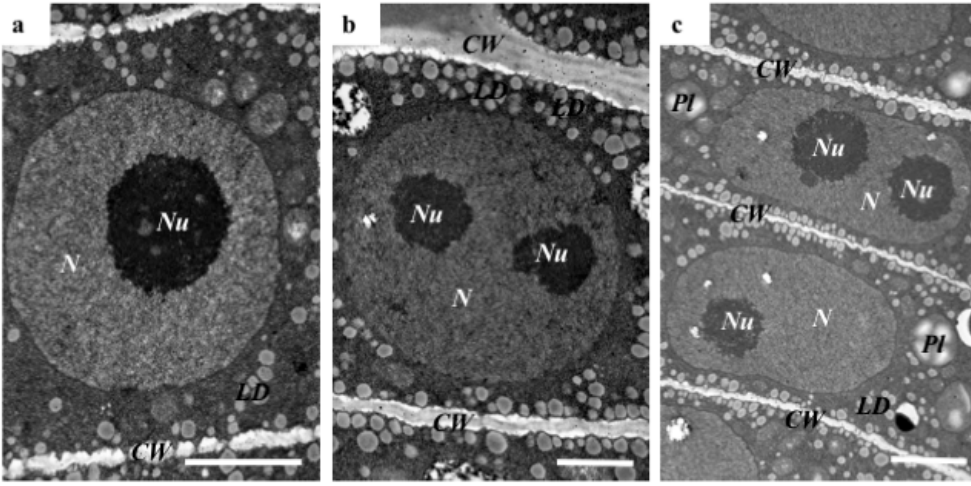
Figure 2. TEM (transmission electron microscopy) of radicula nuclei ( a – c ). Abbreviations: CW —cell wall, LD —lipid droplets, N —nucleus, Nu —nucleolus, Pl —plastid. Bars: ( a ) 3 µm; ( b ) 1.5 µm; and ( c ) 2.5 µm.